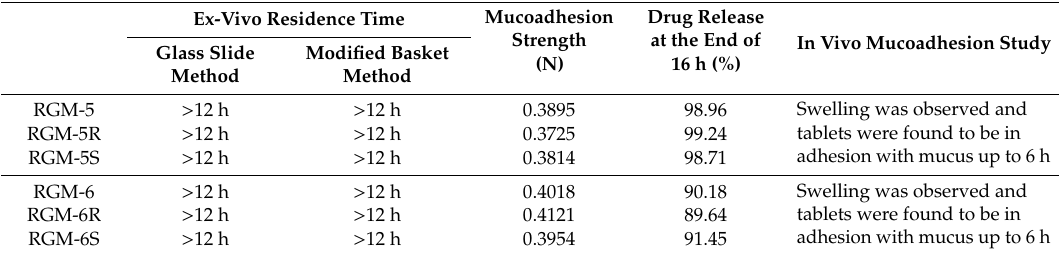
Table 6. Reproducibility of Thiolated Batches by ex-vivo residence time, mucoadhesion strength, percentage drug release at end of 16 h and in-vivo mucoadhesion study.